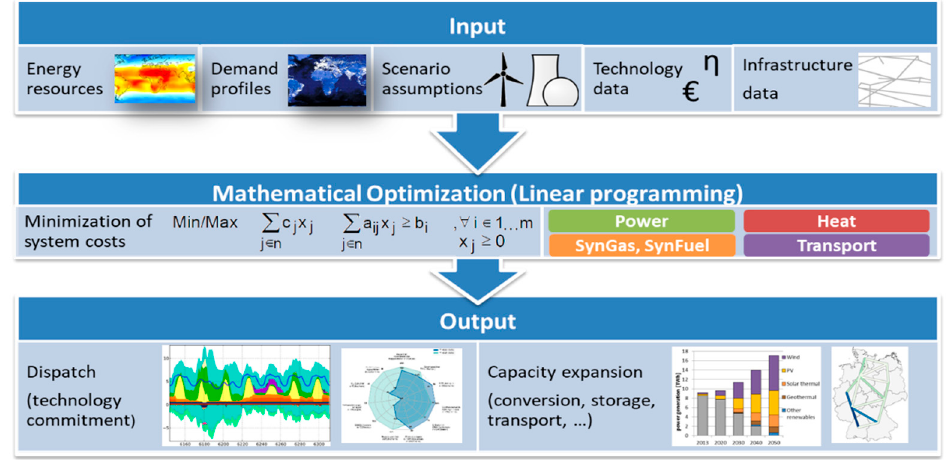
Figure 2. Overview of inputs, method, and outputs of the REMix energy system modelling framework.